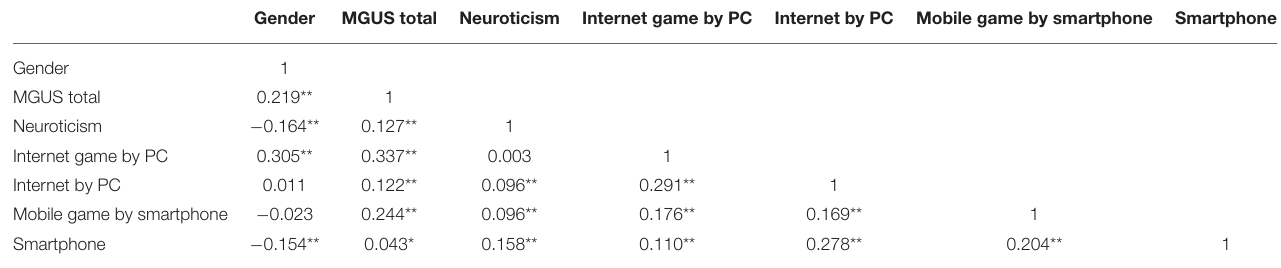
TABLE 2 | Correlation between MGUS total score, usage time, neuroticism and sex.